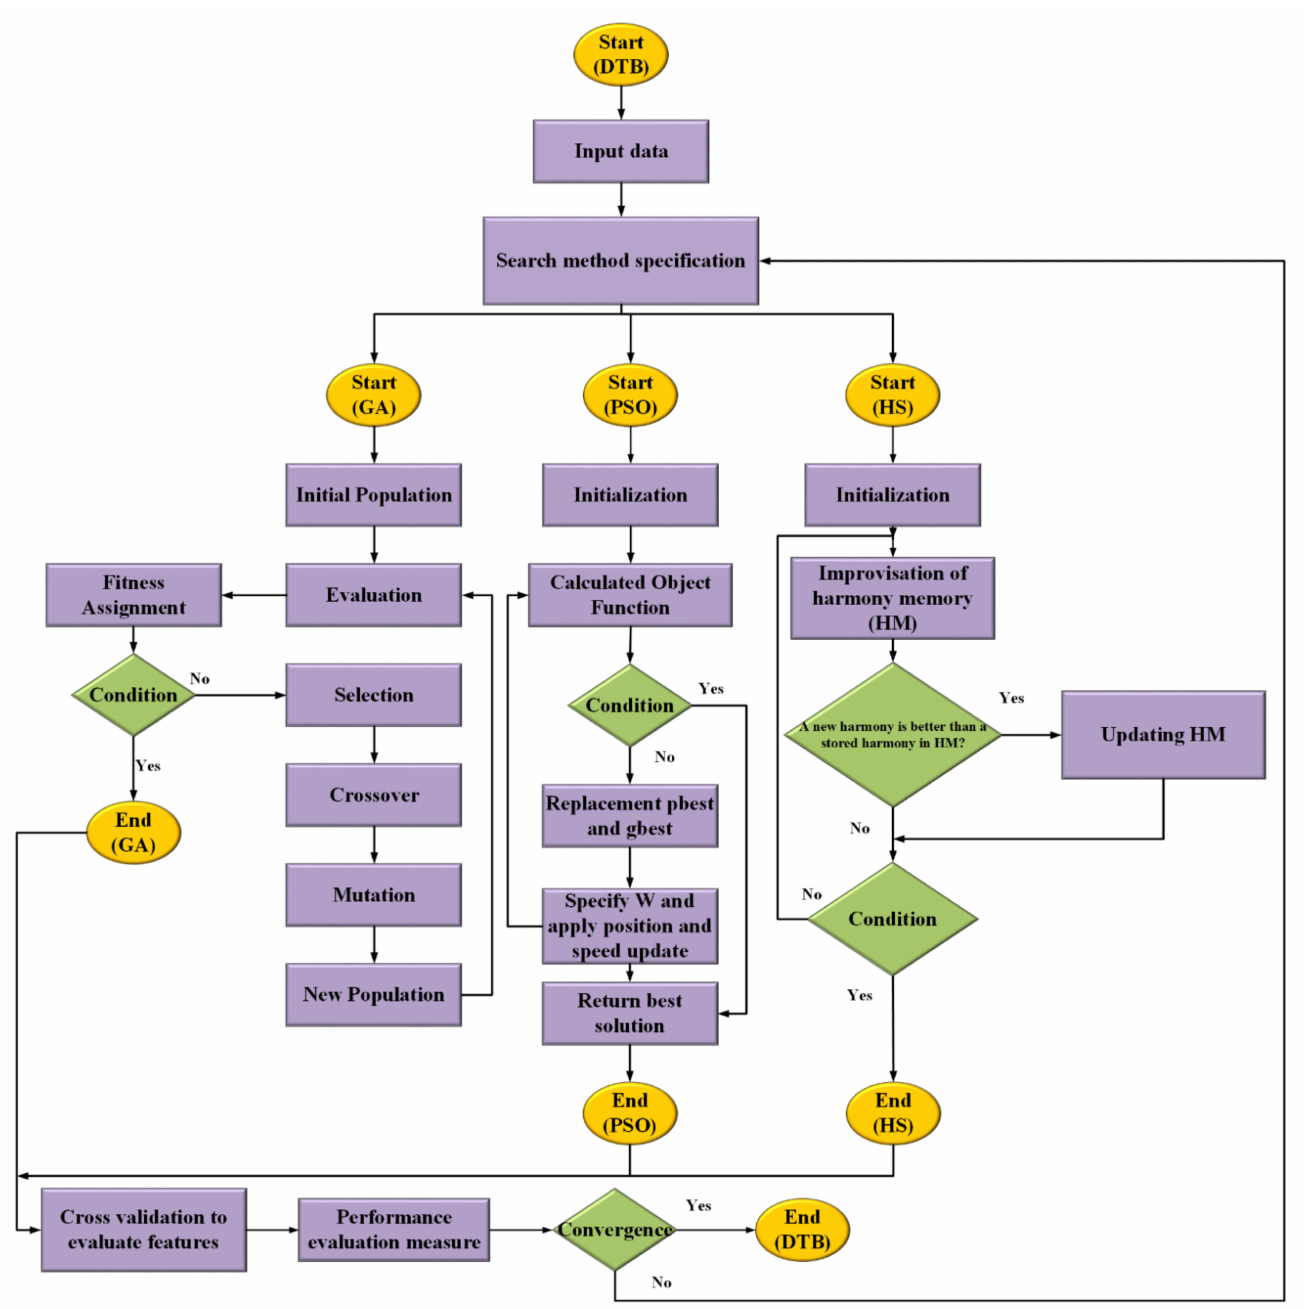
Figure 5. Flowchart of DTB algorithm